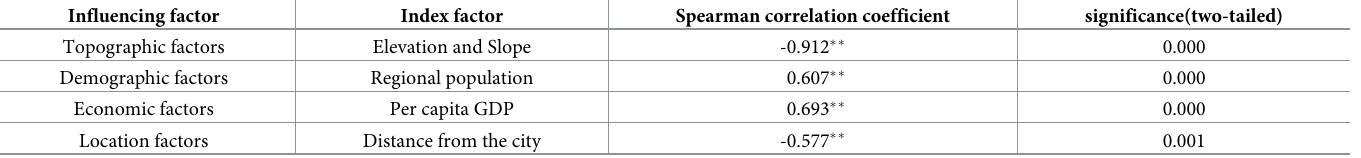
Table 4. Correlation between spatial distribution and geographic space of beautiful leisure villages in